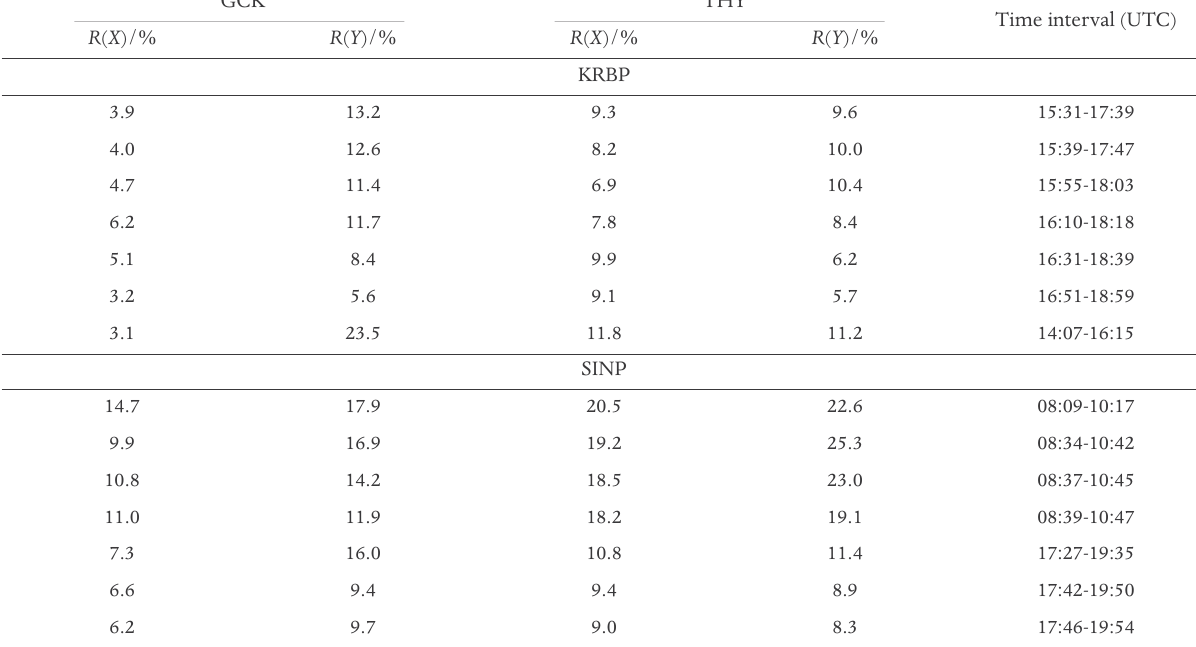
Table 1. Parameters R ( X ) and R ( Y ) between the observatories GCK and THY and repeat stations KRBP and SINP, and selected time inter- vals of plane wave events on July 21 and 22, 2010, for KRBP, and July 26, 2010, for